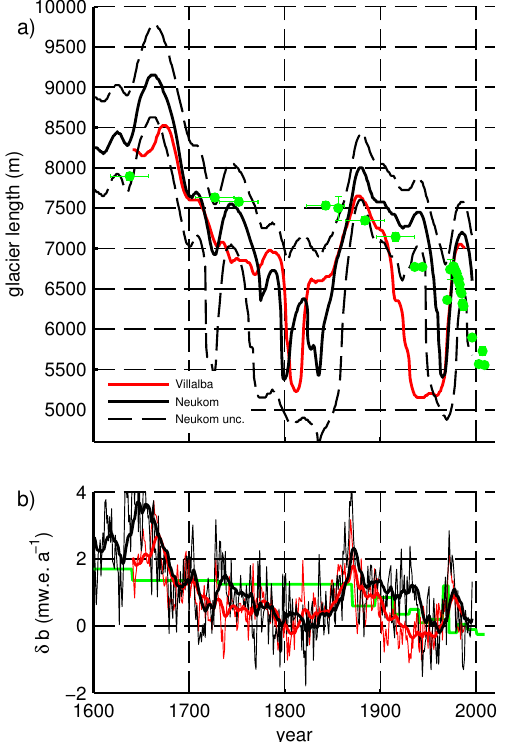
Fig. 11. Results of the model forced with the available precipita- tion (Neukom et al., 2010) and temperature (Neukom et al., 2011; Villalba et al., 2003) reconstructions. (a) Glacier length for the pe- riod 1600–1995 based on Neukom et al. (2011, 2010) (black), with upper and lower estimate (dashed black) indicating the uncertainty; Villalba et al. (2003) temperature, Neukom et al. (2010) precipi- tation (red); observations (green dots), with uncertainty intervals. (b) δb calculated from the annual mass balance profiles from the reconstructions by Neukom et al. (black), Villalba et al. (red), with 21-yr exponential smoothing, and δb obtained from dynamical cal- ibration (green) (cf. Fig.